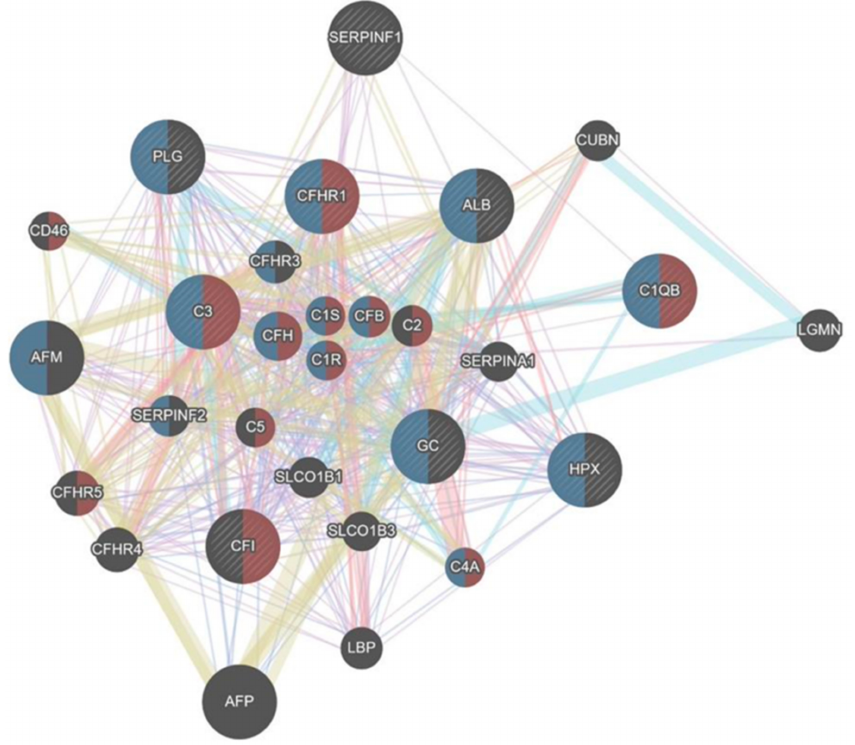
Figure 8. Bio-Informatical Network Analysis HH 60 vs.